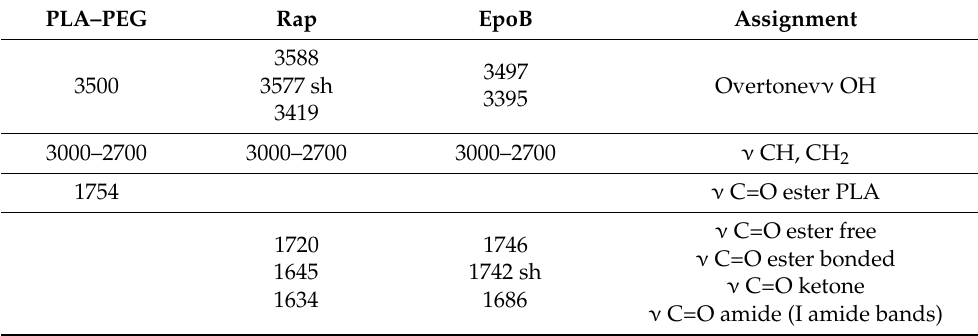
Table 4. Assignment of the bands in selected regions of FTIR spectra for the investigated compounds.